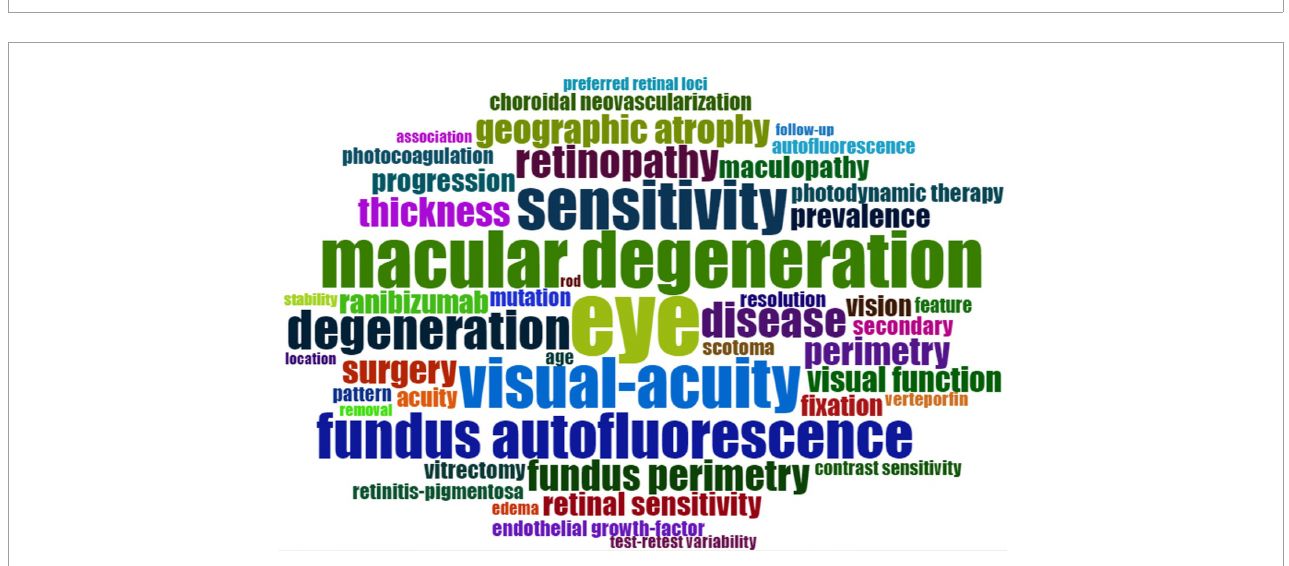
FIGURE13 Wordcloud of microperimetry research. The size of terms represented the frequency of